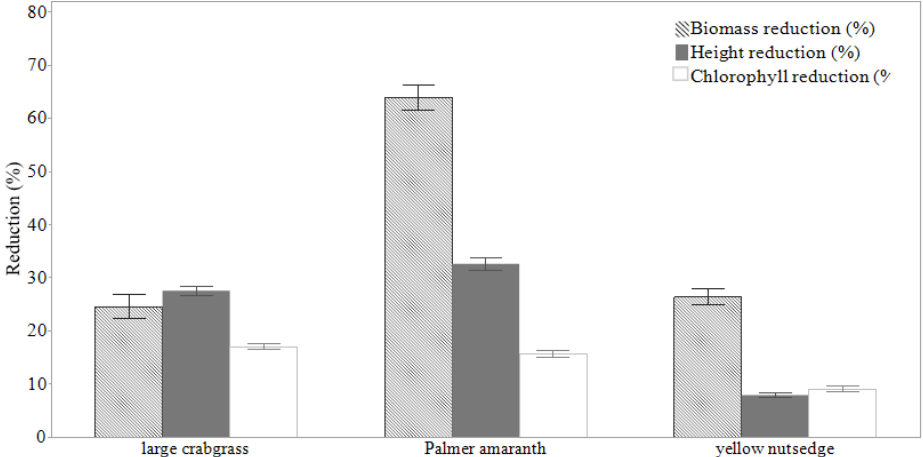
Figure 2. Average seedling height, biomass, and chlorophyll reduction (%) of Palmer amaranth, yellow nutsedge, and large crabgrass, at 28 days after sowing. Four tomato plants and four plants of a single weed species were grown together in one pot. The reduction values were based on a comparison to plants of individual weed species grown as a control treatment without tomato interference. Error bars represent the standard deviation of the mean. Palmer amaranth shoot biomass was considerably decreased due to the interference of tomato cultivars ( p = 0.0001), and the percentage of reduction ranged from 25 to 80% (Figure 4). The maximum reduction of dry biomass in Palmer amaranth was due to the influence of the tomato cultivars 33 (83%) and 15 (83%), whereas the minimum biomass reduction was due to cultivar 10 (25%) (Figure 4). Yellow nutsedge biomass decreased about 40% with the interference of cultivar 15, but most of the cultivars did not reduce the biomass by more than 30% ( p = 0.0048). Overall, 60% of tomato cultivars resulted in bio- mass reduction of large crabgrass by more than 20% ( p = 0.0137). The highest biomass reduction in large crabgrass among the cultivars was due to cultivar 63 (45%), followed by cultivar 64, 33, and 38, with about 40% reduction. The least suppressive effect was ob- served with cultivar 18 (5%).